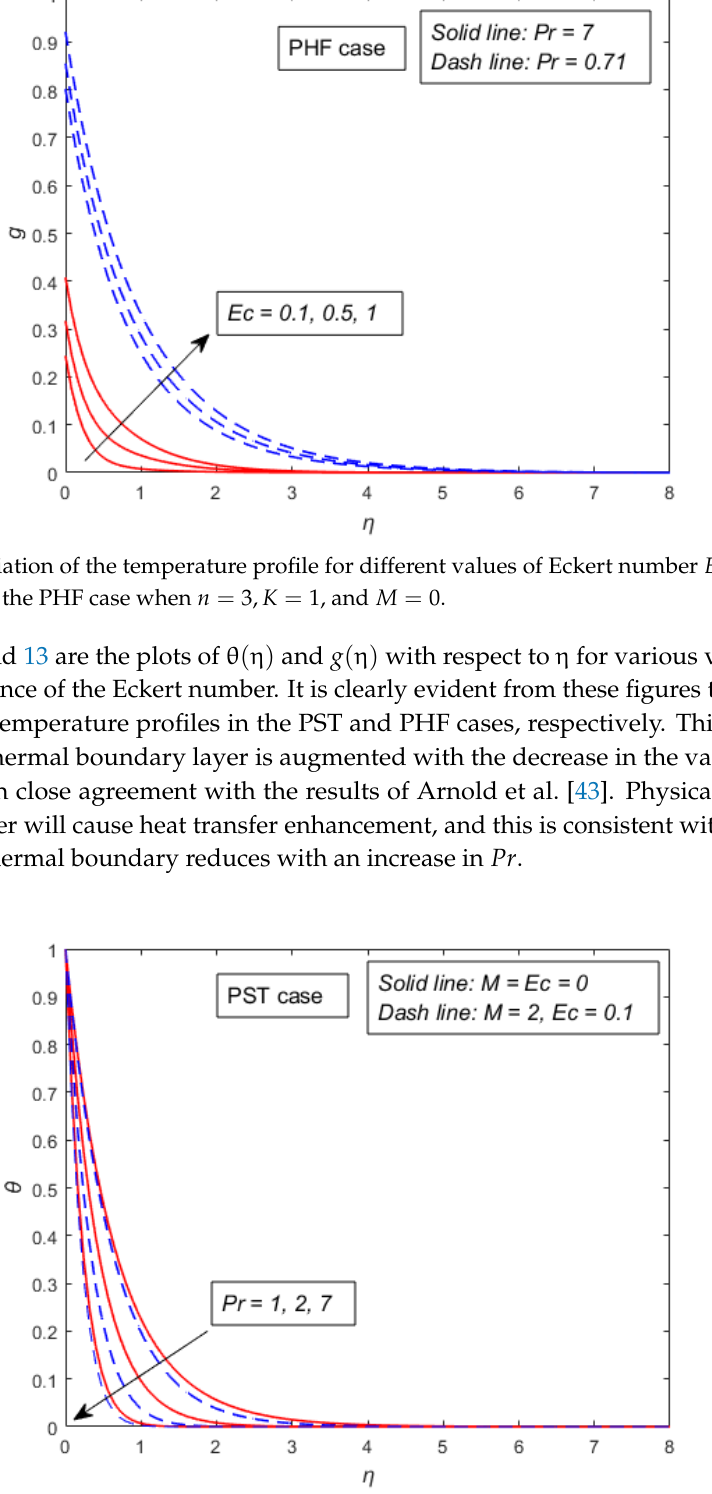
Figure 12. Variation of the temperature profile for different values of Prandtl number Pr , Eckert number Ec , and magnetic parameter M on the temperature profile for the PST case when n = 3 and K =